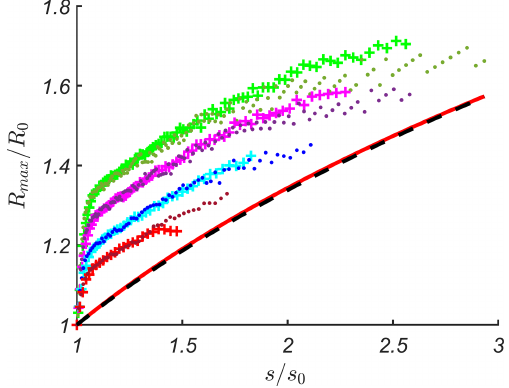
Figure 10. The ratio of maximum run-up height in the conjoined basin, R max /A , and the maximum run-up height on a plane beach, R 0 /A , versus the wave front steepness, s/s 0 , for A/h 0 = 0 . 057, kh 0 = 0 . 38 (brown points); A/h 0 = 0 . 086, kh 0 = 0 . 38 (red plus signs); A/h 0 = 0 . 057, kh 0 = 0 . 29 (blue points); A/h 0 = 0 . 086, kh 0 = 0 . 29 (turquoise plus signs); A/h 0 = 0 . 057, kh 0 = 0 . 22 (vi- olet points); A/h 0 = 0 . 086, kh 0 = 0 . 22 (pink plus signs); A/h 0 = 0 . 057, kh 0 = 0 . 19 (dark-green points); and A/h 0 = 0 . 086, kh 0 = 0 . 19 (light-green plus signs). All markers correspond to the results of numerical simulations, while the asymptotic analytical predic- tions are given by the red solid line. Black dashed line corresponds to the power fit of the analytical results of Eq. (16).